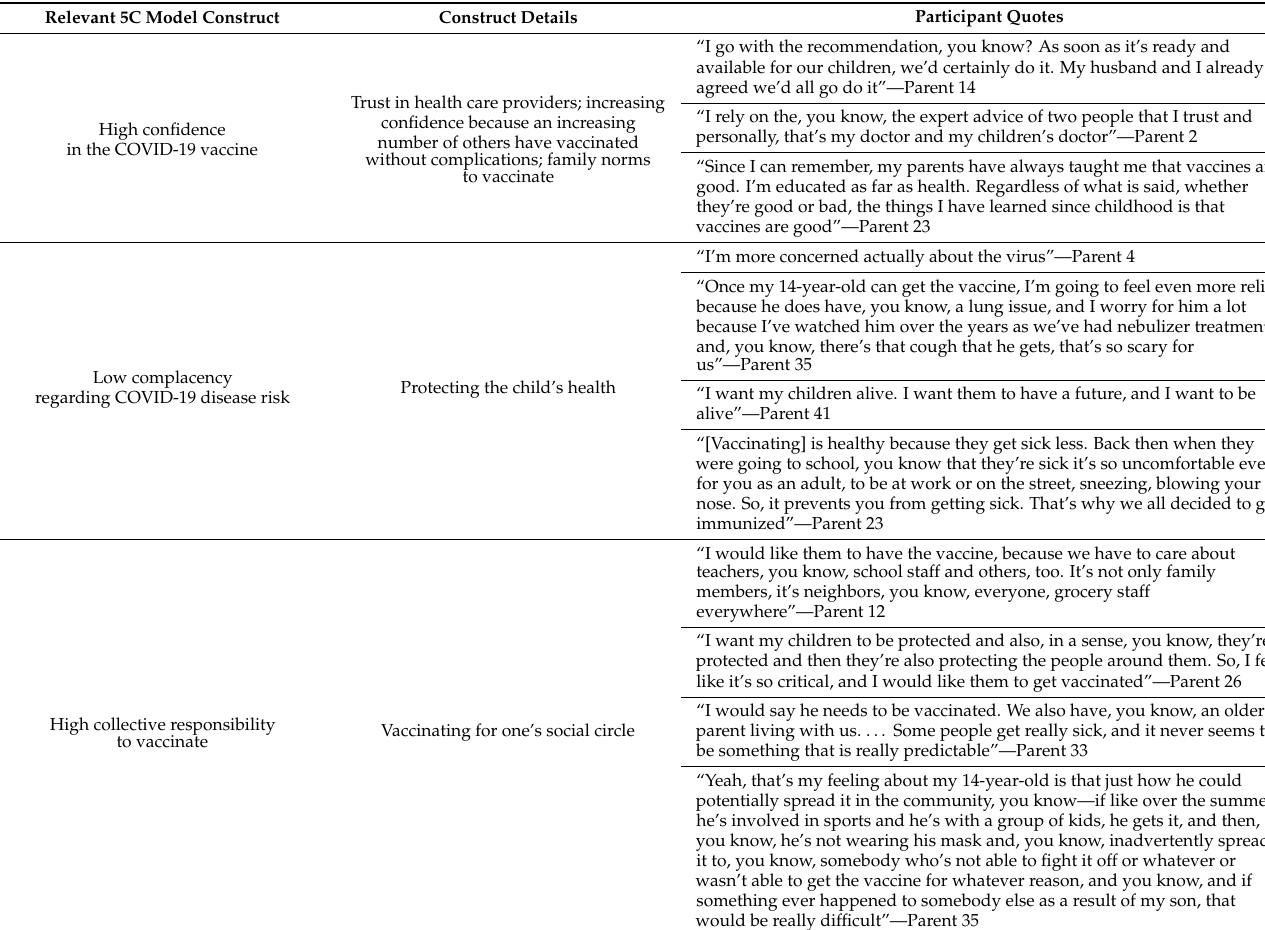
Table 5. Vaccine